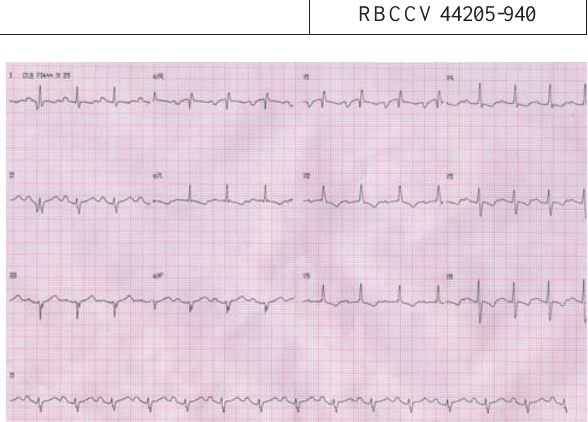
Fig. 1 – Eletrocardiograma com sobrecarga atrial esquerda e ventricular direita, bloqueio divisional ântero-superior e bloqueio atrioventricular de 1º grau